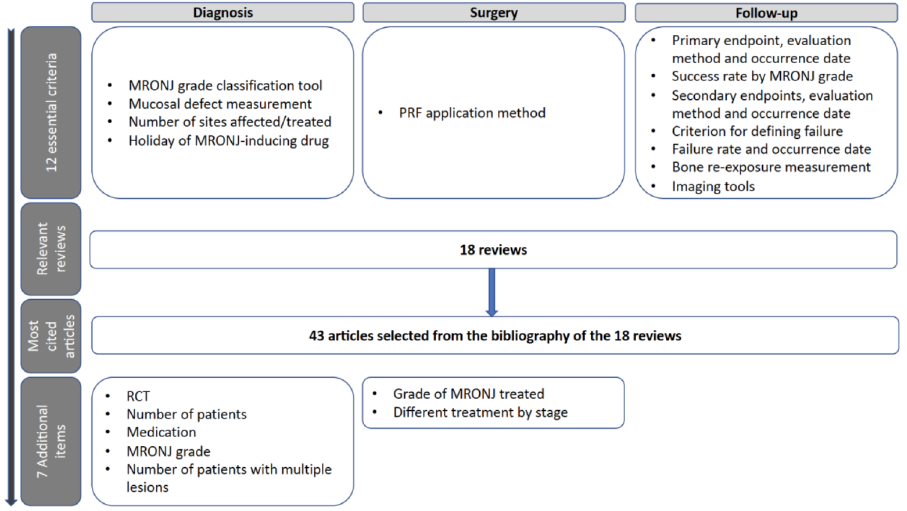
Figure 1. Summary of the curative steps applied to the selected references.